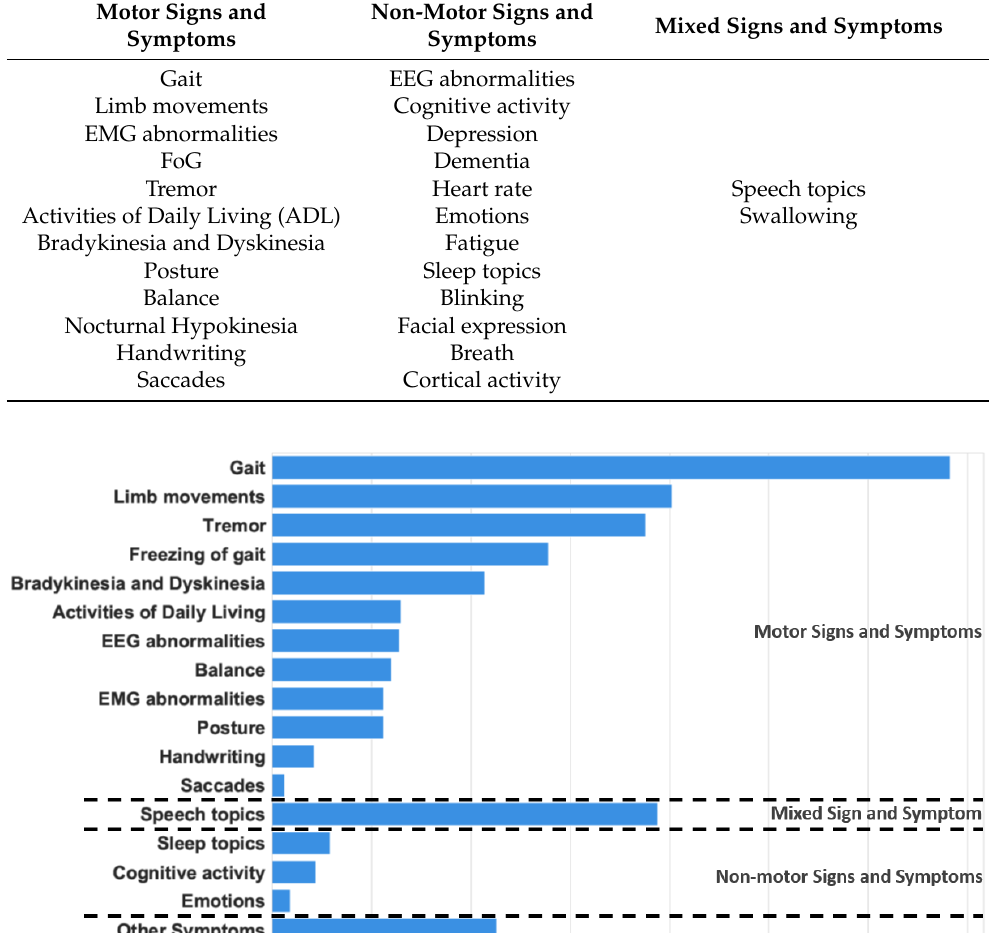
Table 1. The signs and symptoms assessed by technology in the current literature.